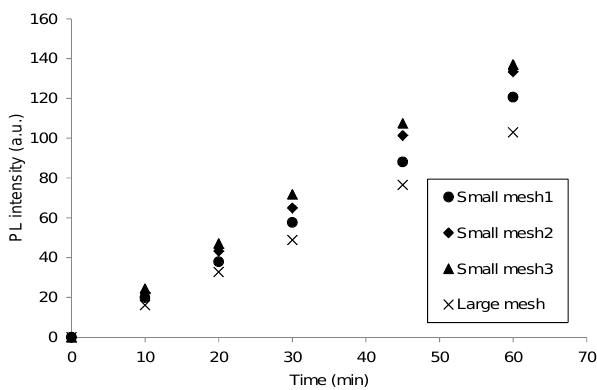
Figure 9. Light transmission through uncoated woven meshes (for which r = 0.48) in a non-absorbing medium (distilled water). The solid line represents model calculations according to Eq. (1); ( × ) measured intensities with 1cm mesh separation. Inset: reflection of stainless steel flat plate and TiO 2 film measured with the integrated sphere